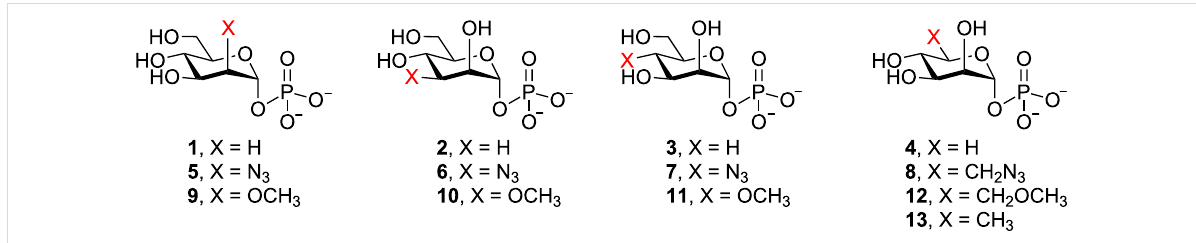
Figure 2: Structures of the Man p -1P derivatives ( 1 – 8 ) previously shown [24,25] to be substrates for S. enterica GDP-ManPP and analogues 9 – 13 studied in this